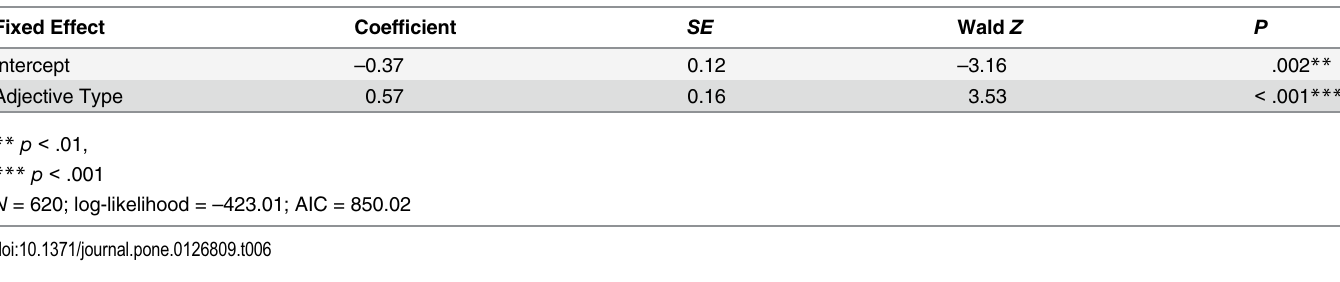
Table 6. Summary of logistic regression predicting the likelihood of a round name